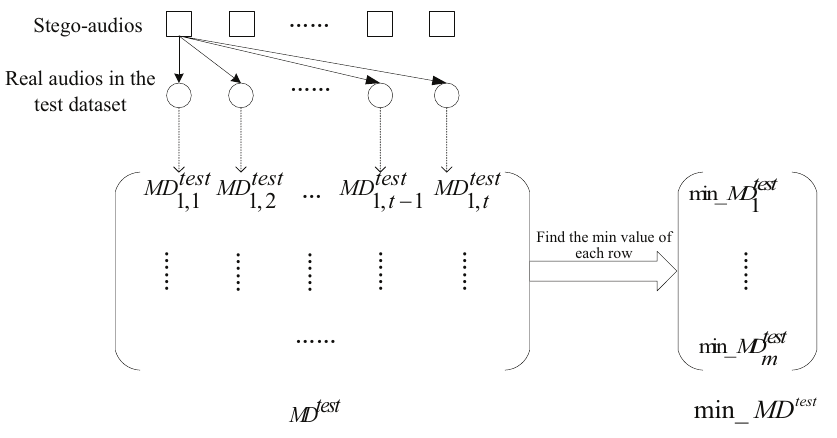
Figure 9. Illustration of Step (2).